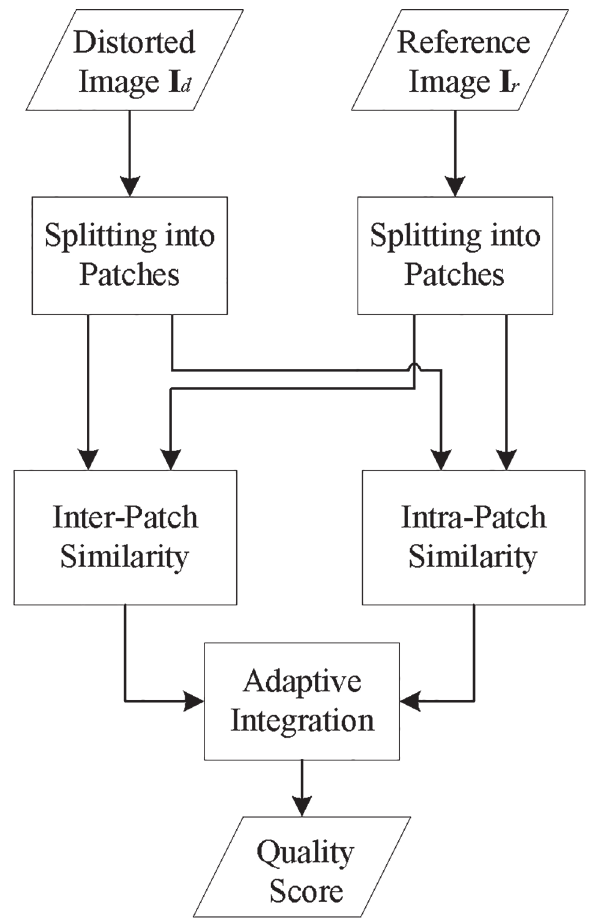
Fig 1. Overall framework of the proposed IQA